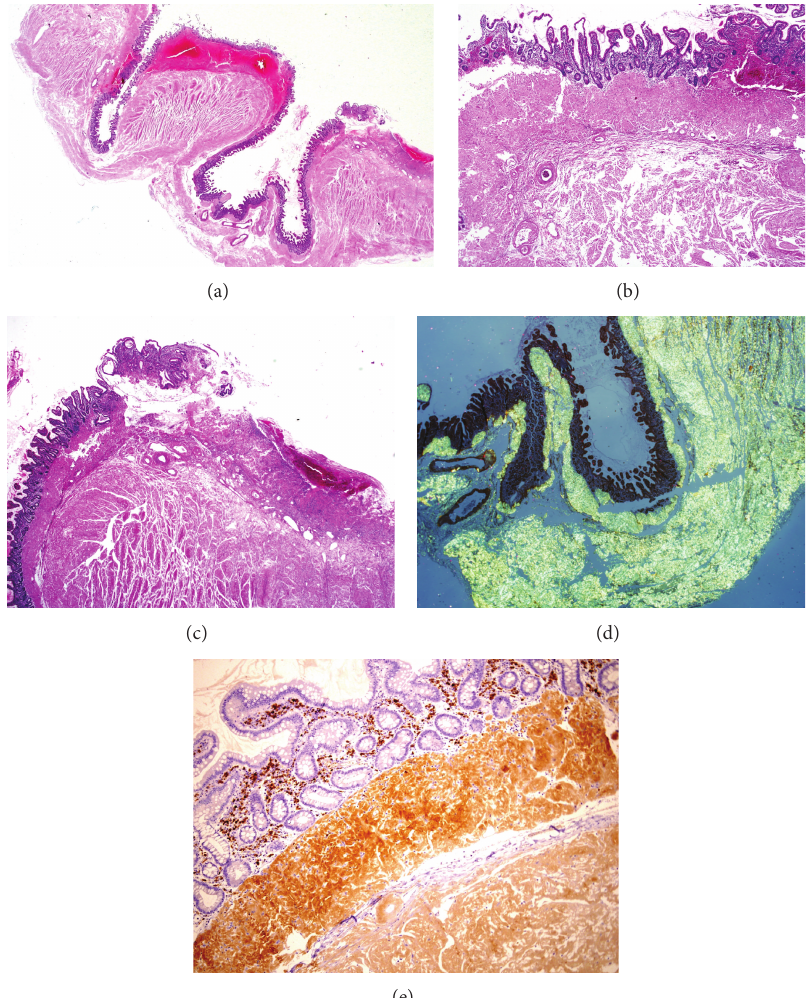
Figure 1: (a) Whole mount section of the small intestine showing diverticular disease (hematoxylin and eosin stained section, magnification × 8). (b) and (c) show extensive deposition of eosinophilic amorphous material (amyloid) in the muscularis mucosa, submucosa, and muscularis propria layers of the small bowel. Ischemic mucosal ulceration and hemorrhages are present in (c) (hematoxylin and eosin stained sections, (b) magnification × 40 and (c) magnification × 20). (d) Congo red stain under polarized light shows extensive green